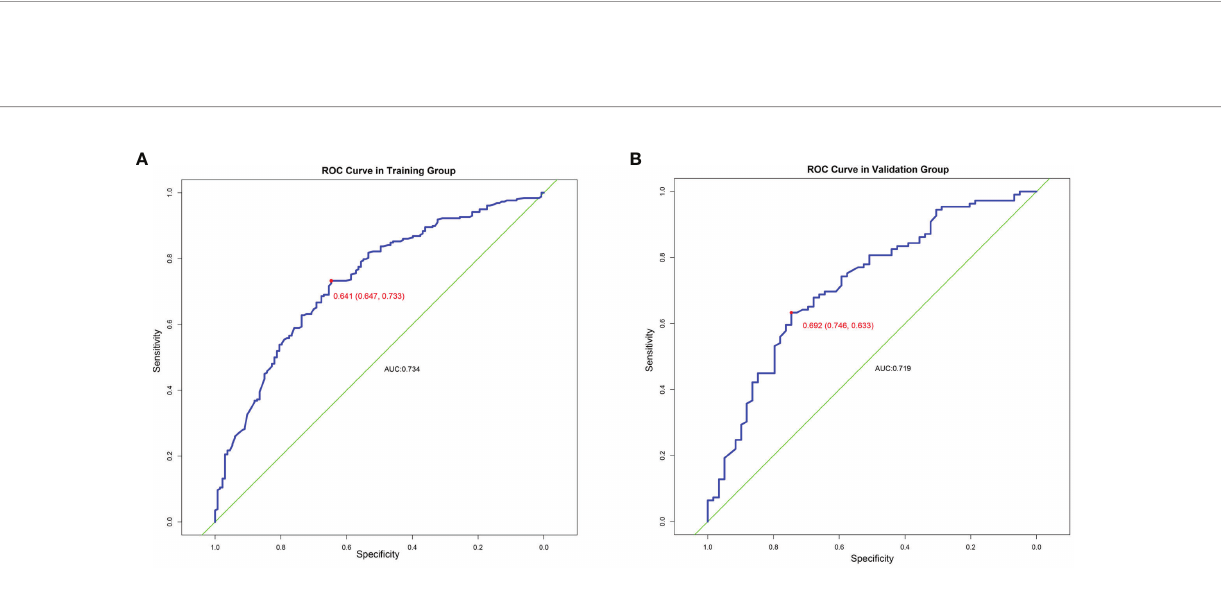
FIGURE 8 | ROC curve on training group (A) and validation group (B)